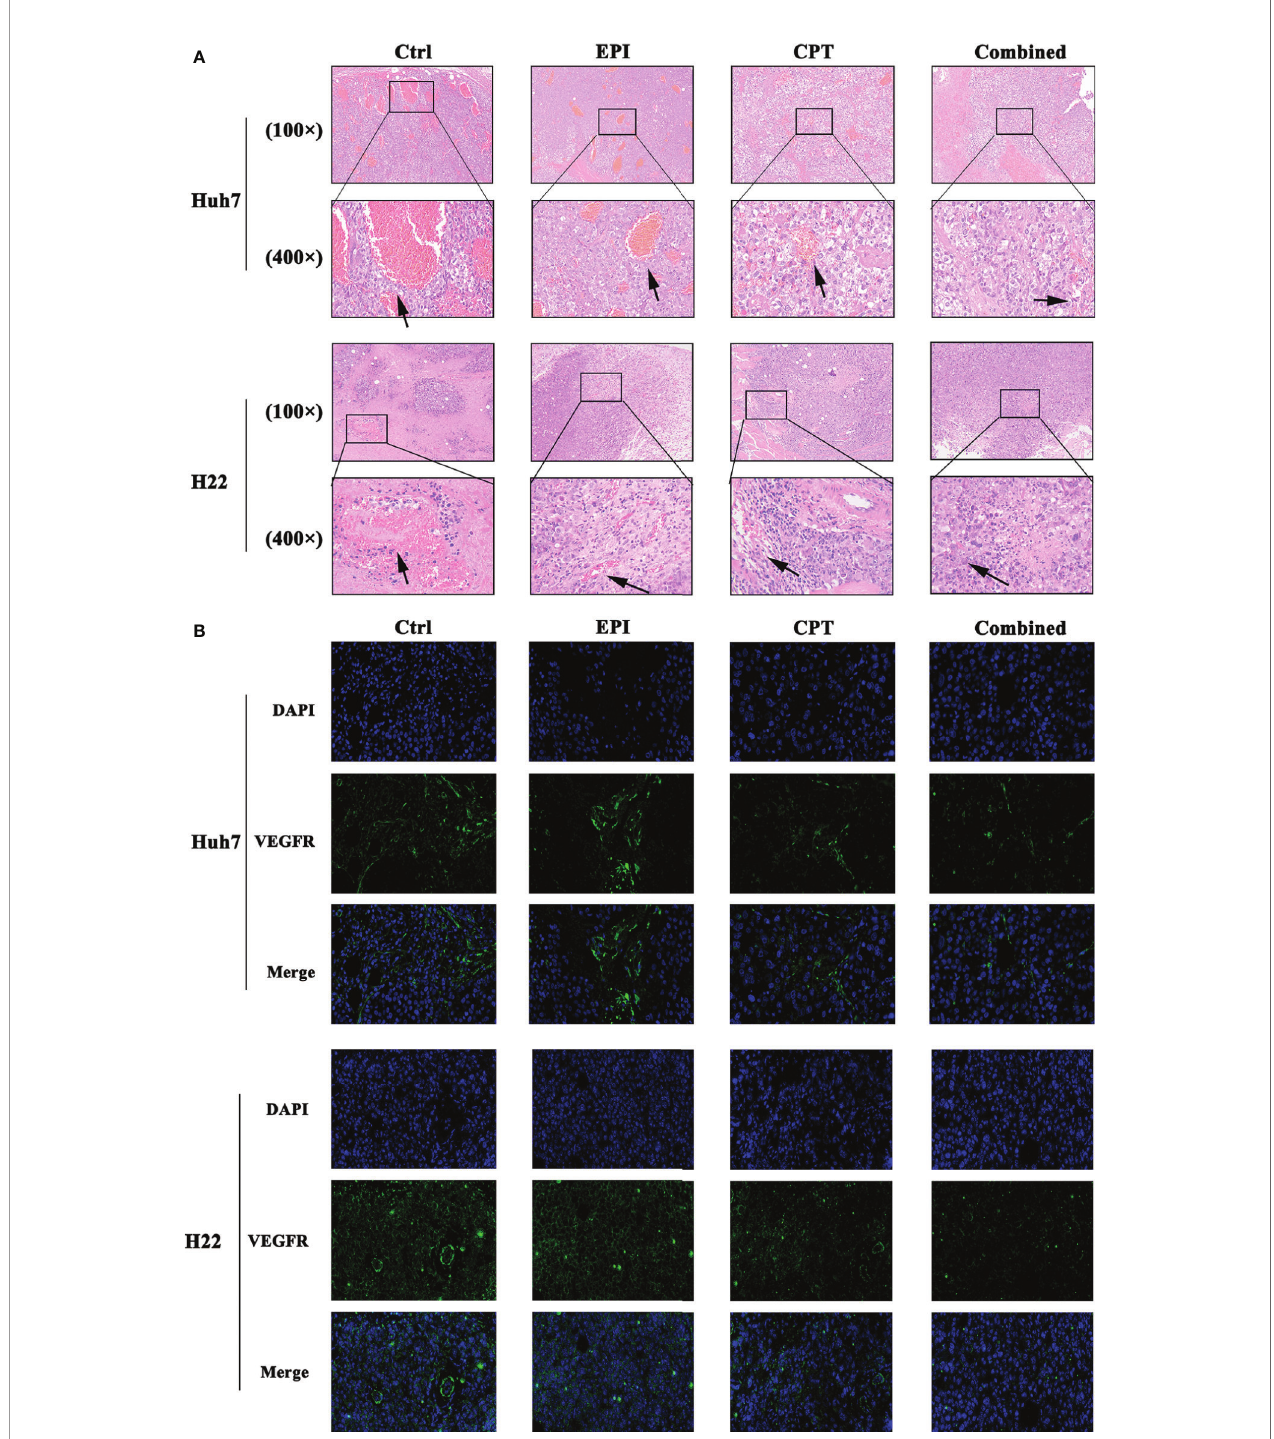
FIGURE 7 | CPT administration favors suppression of angiogenesis. (A) The H&E staining of the Huh7 and H22 tumors at 100× and 400× magni fi cation. The arrow showed the vessel inside the tumor. (B) The IF staining of VEGFR (green) in Huh7 and H22 tumor at 400× magni fi cation. DAPI (blue) indicated the nucleus of the tumor